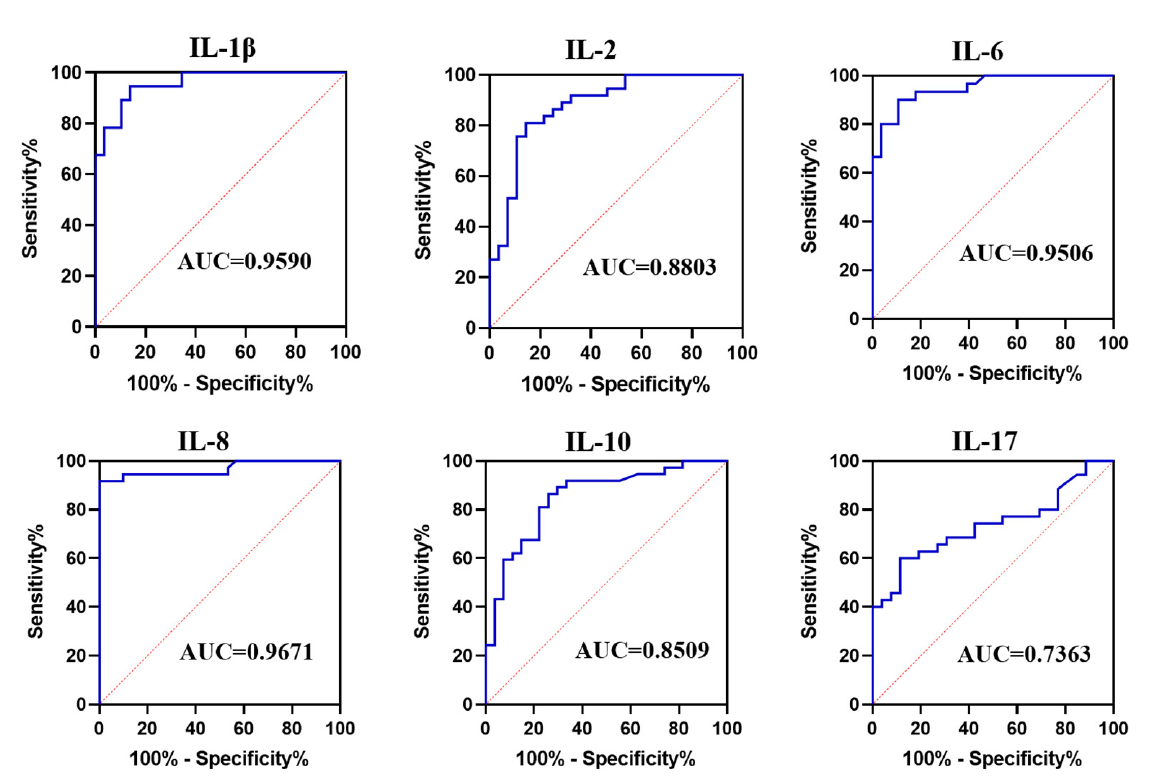
Figure 2. Receiver Operating Characteristic curves (ROCs) and area under curves (AUC) of partial synovial fluid interleukin in distinguishing between PJI and aseptic